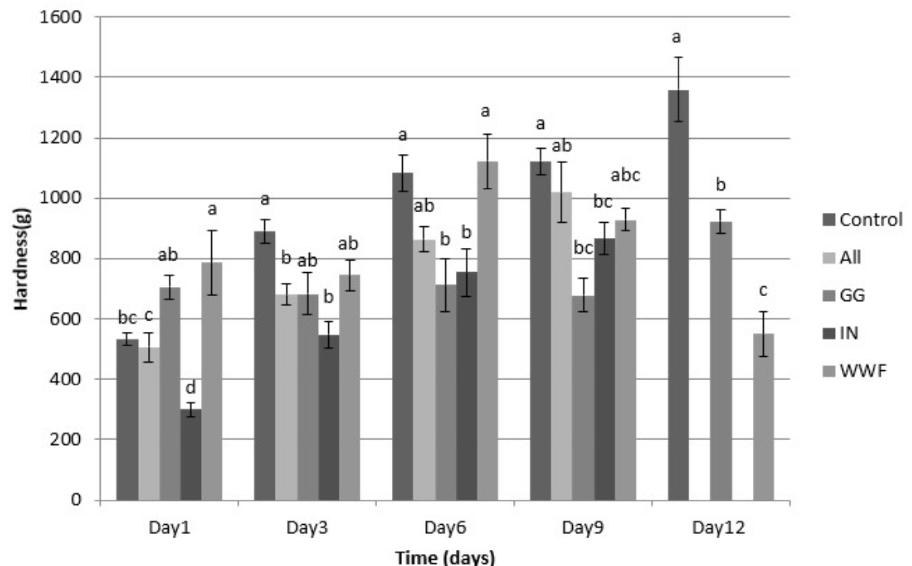
Figure 3. The impact of the added FI on Pita breads hardness(g) over the storage period. Values are mean ± SEM of 6 replicates; a, b and c letters indicate statistically significant differences ( p < 0.05) between means.